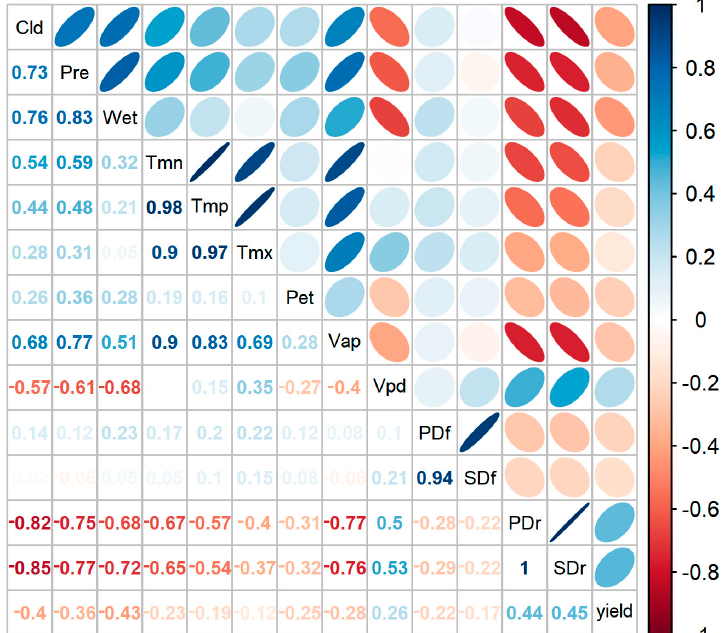
Figure 3. Exploratory data analysis (EDA) results showing the correlations among 13 variables and correlations (R) between each climate variable and maize yield (statistical significance was tested using single-factor analysis of variance, p <0.05 ). The color and size of the dots indicate the correlation strength. The low correlations ( p >0.05 ) were not displayed in the figure. 3.2. Multi-Model Performances When Estimating Maize Yield The first group of experiments used different combinations of climate, satellite data, and meteorological indices to evaluate model performance. The prediction performances of the seven forms of data inputs were evaluated across four machine learning algorithms (Figure 4). The results showed that the combination of climate, satellite data, and meteor- ological indices achieved the best performance, with R values ranging from 0.742 to 0.828. Indeed, the combination of the climate data and meteorological indices performed best, following by the combination of climate data with satellite data and the combination of meteorological indices with satellite data. Additionally, the performance of climate data only, with R values between 0.641 and 0.752, was better than that of satellite data only and meteorological indices only, with the lowest R values ranging from 0.460 to 0.487 0.449 to 0.486, respectively. Furthermore, the analyses clearly showed that the cubist model gen- erally provided the best accuracy among the four learning methods in estimating R, fol- lowed by RF, Xgboost, and SVM.